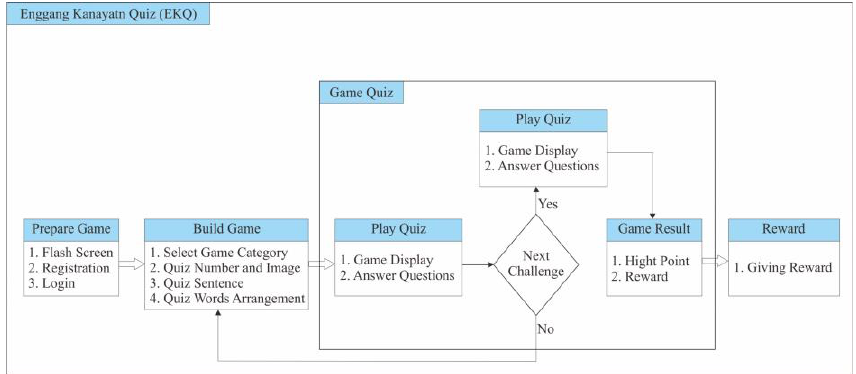
Fig. 1. Research Flow